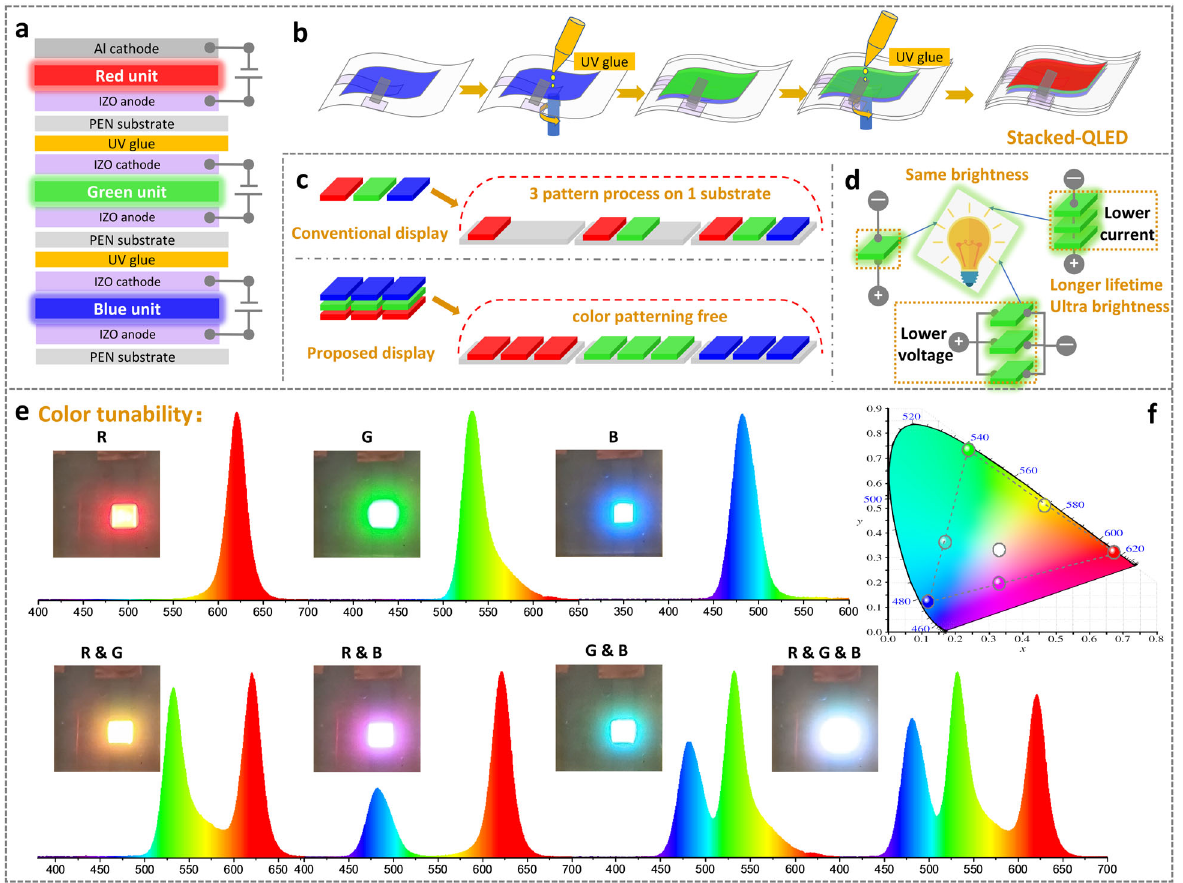
Fig. 2 Tandem QLED with individually addressable R/G/B emission. a The schematic device structure and b assembling processes of the tandem LED. c Comparison of a conventional full-color display with patterned horizontal R/G/B side-by-side pixel arrangement, and our proposed display with the color-patterning-free vertical R/G/B pixel con fi guration. Compared to conventional scheme, our method can signi fi cantly improve the resolution and the aperture ratio of a display. d The LED elements can be connected either in series or in parallel mode, and thus our tandem LED can display a high brightness either at a very low current or at a very small voltage, which is bene fi cial to their lifetime. e Photos and spectra of the tandem QLEDs demonstrating that the R/G/B emission can be separately controlled and tunable colors can also be achieved by varying the driving signals. f The color coordinates of the achievable colors by the tandem The performances of the red, green, and blue emission in the tandem structure are then evaluated. As shown in Fig. 3a, b, by assembling the red, green, and blue LED elements as a tandem device, their EQEs are reduced from 17.2%/16.3%/6.0% to 12.0%/